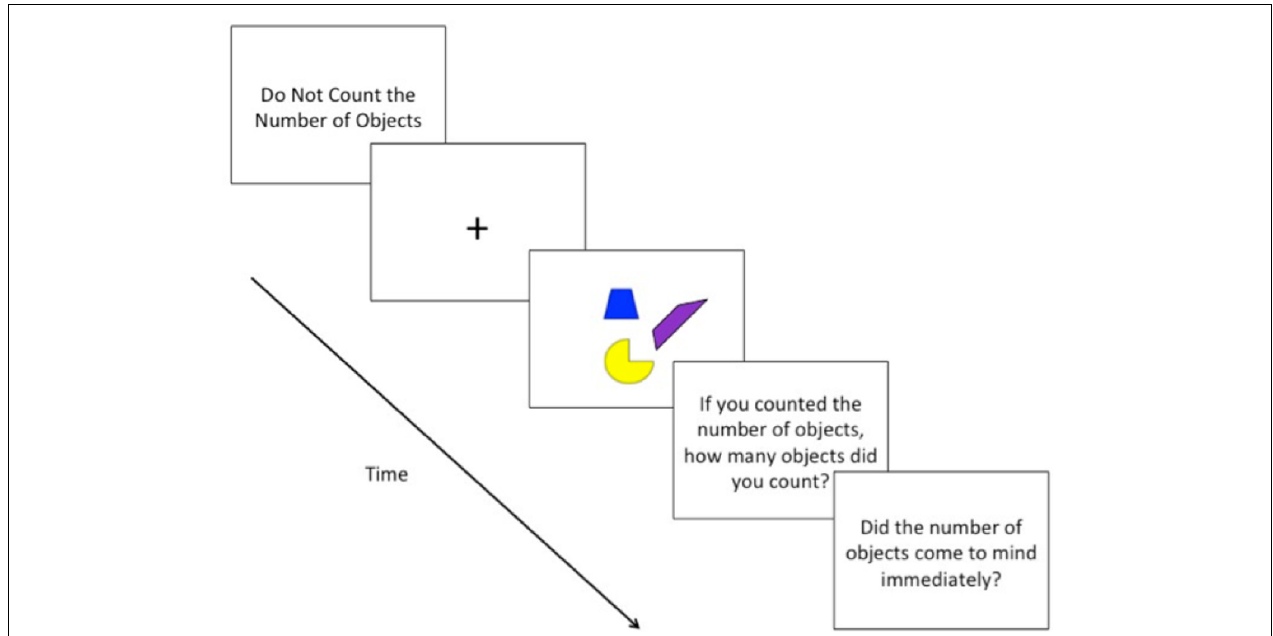
FIGURE 2 | Schematic depiction of a typical trial with an array of objects presented in different colors.